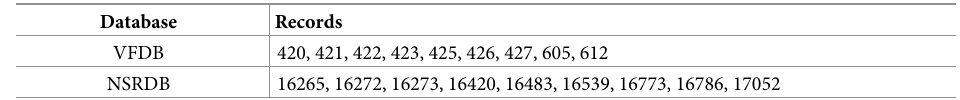
Table 1. List of records used in this